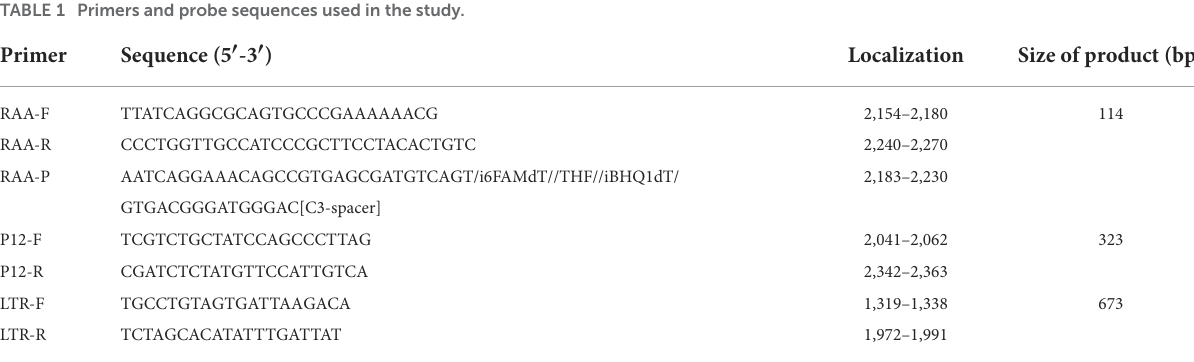
TABLE 1 Primers and probe sequences used in the